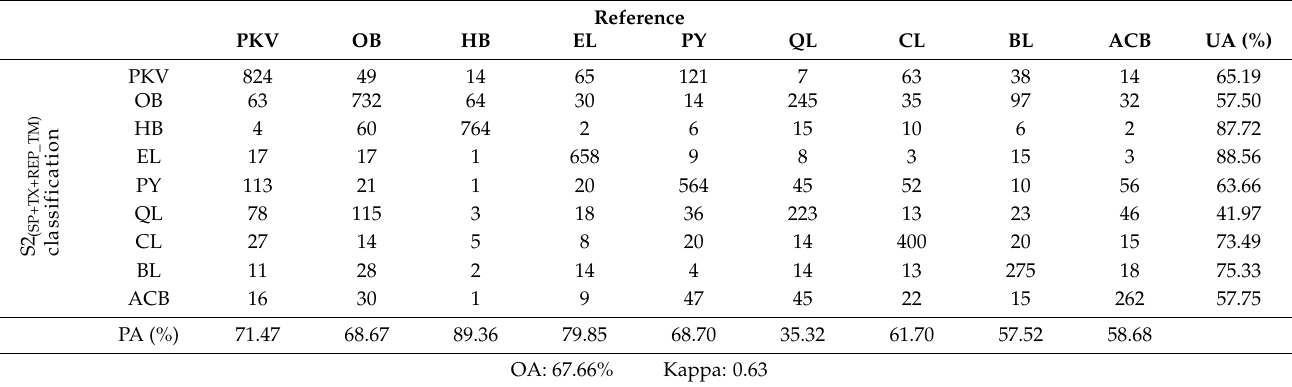
Table A3. Confusion matrix derived using only Sentinel-2 spectral and texture features and REP time-series